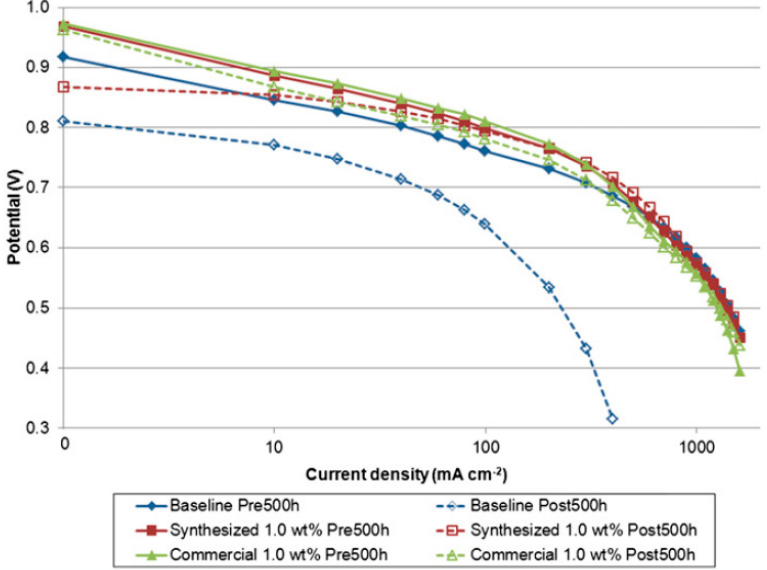
Figure 6. Pre- and post 500 h test performance curves; reproduced with permission from